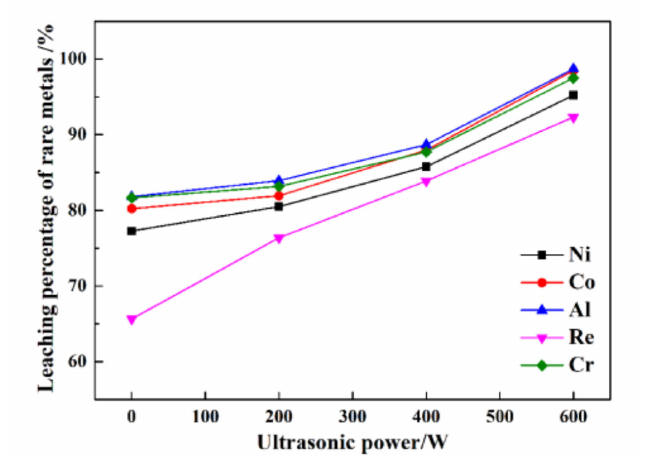
Figure 3. The leaching percentages of rare metals under different ultrasonic